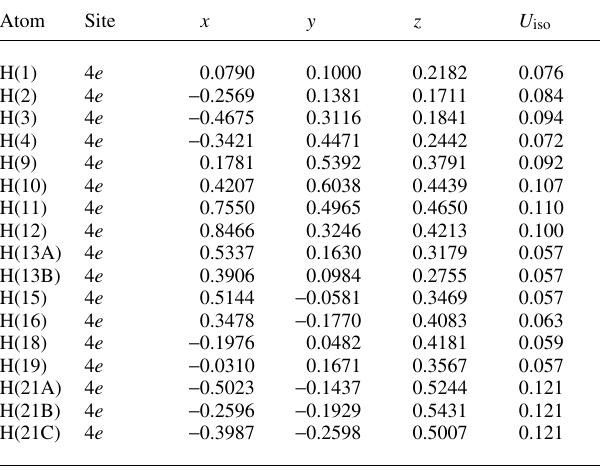
Table 2. Atomic coordinates and displacement parameters (in Å 2 )